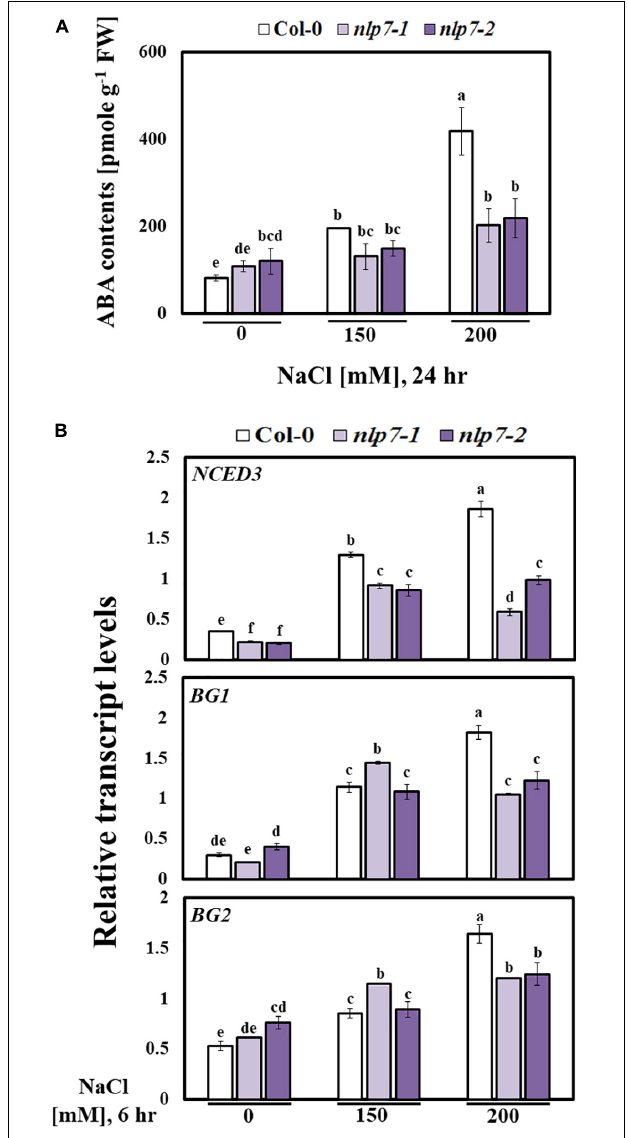
FIGURE 9 | Abscisic acid accumulation was decreased in the nlp7 mutant under salt stress. (A) Comparison of the abscisic acid ( ABA) content between Col-0 and nlp7 plants. Nine-day-old Col-0, nlp7-1 , and nlp7-2 seedlings were germinated and grown on a nitrogen-free half-strength MS medium containing 5 mM KNO 3 and then treated with 0, 150, or 200 mM NaCl for 24 h. Error bars represent the standard deviation of three independent replicates. (B) Comparison of the relative transcript levels of the ABA-related genes, such as NCED3 , BG1 , and BG2, in Col-0 and nlp7 plants. The seedlings were grown, treated, and analyzed as described in Figure 8C . AtActin2 was used as the internal control. Error bars represent the standard deviation of three independent replicates. Different letters (a, b, c, d, e, or f) within a treatment group indicate significant differences in the two-way ANOVA ( P ≤ 0.05, Tukey’s